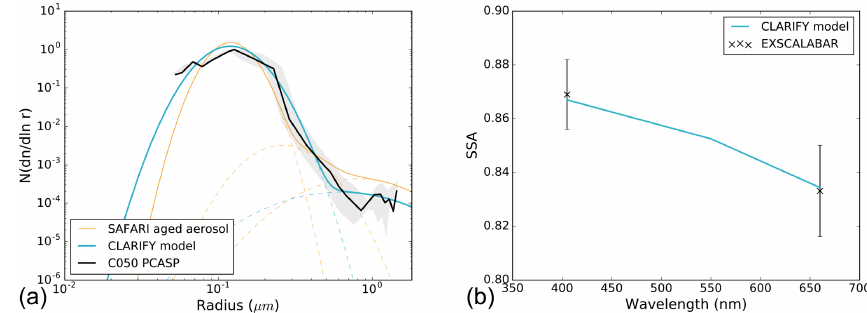
Figure 4. Normalized size distribution (a) and SSA (b) measured above clouds during flight C050 of the CLARIFY-2017 campaign (black). The grey shaded area represents the PCASP measurement and calibration uncertainties. Blue lines represent the fitted aerosol model, the orange lines correspond to the aged aerosol size distribution from SAFARI (Haywood et al., 2003), and the dashed lines show the contribution of each mode. CLARIFY-2017 aerosol model: [ R fine , σ fine , N fine ; R coarse , σ coarse , N coarse ] = [0.12µm, 1.42, 0.9996; 0.62µm, 2.23, 0.0004], refractive index = 1.51–0.029 i . SAFARI aged aerosol model: [ R 1 , σ 1 , N 1 ; R 2 , σ 2 , N 2 ; R 3 , σ 3 , N 3 ] = [0.12µm, 1.30, 0.996; 0.26µm, 1.50, 0.0033; 0.80µm, 1.90,